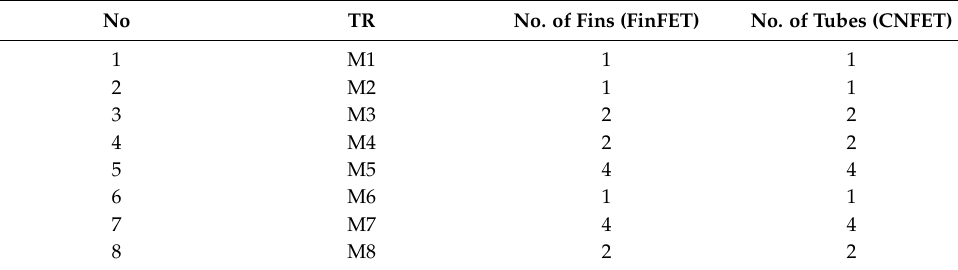
Table 1. Size of FinFET and CNFET in PLNA 8T